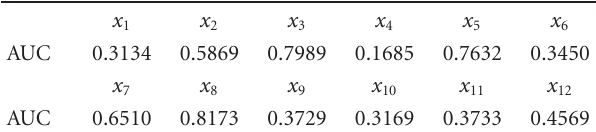
Table 7: ROC curve